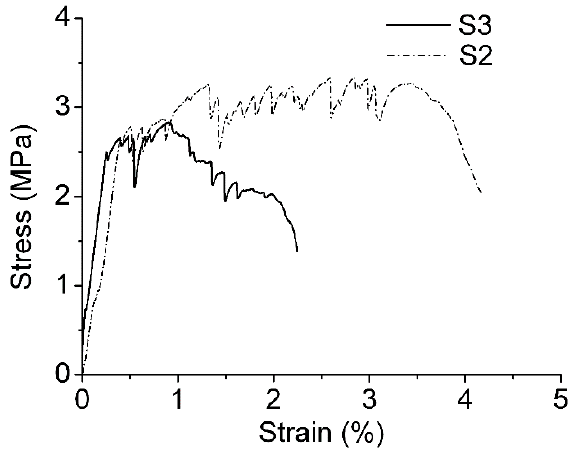
Figure 9. Stress-strain curve of S2 and S3.